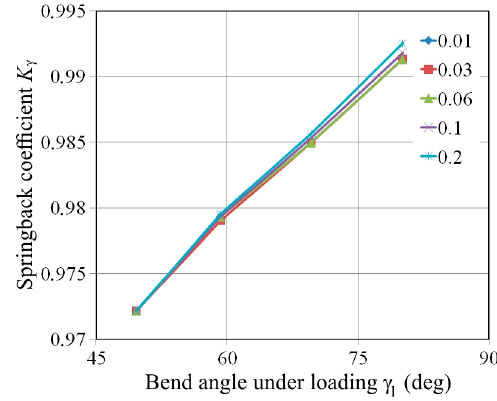
Figure 12. Effect of bend angle under loading on the springback coefficient K γ determined for sample orientation 0.